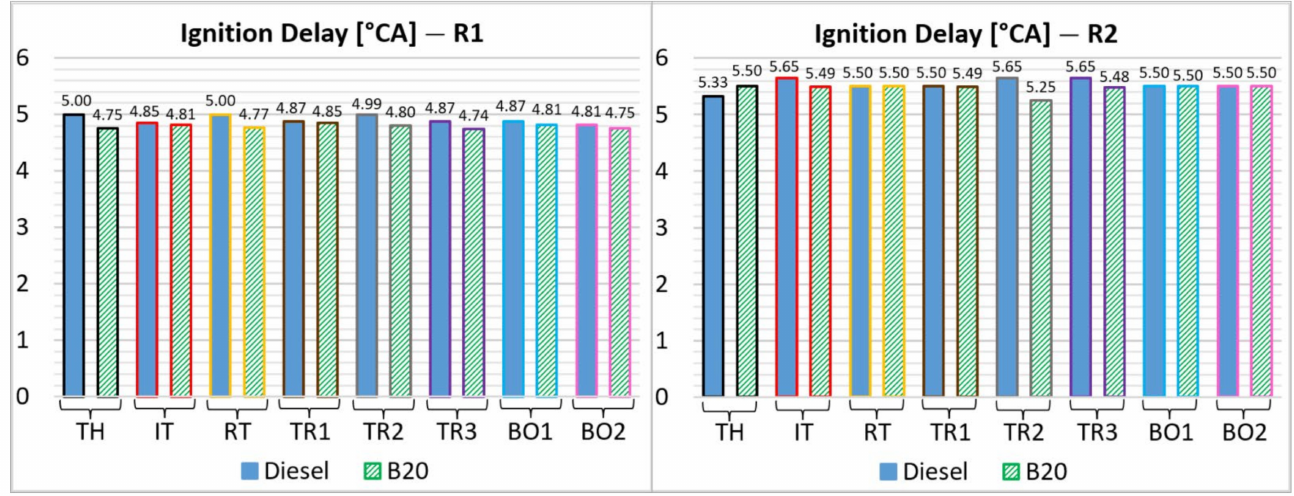
Figure 5. Ignition delay variation by different shapes of